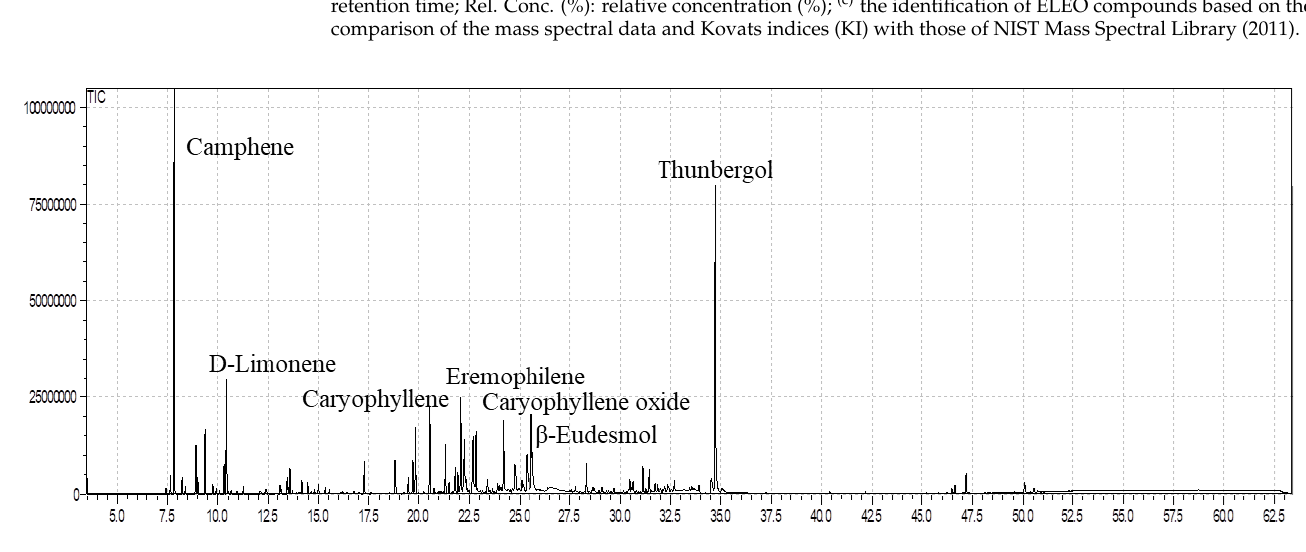
Figure 1. GC-MS analysis of the essential oil of E. larica .